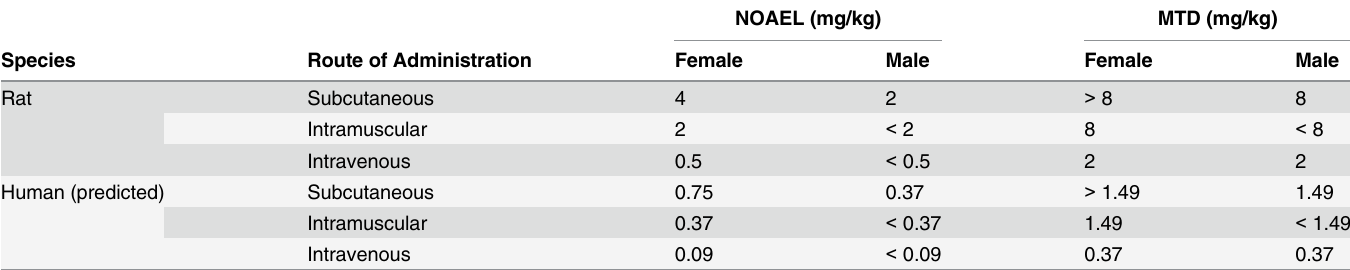
Table 5. Estimation of allopregnanolone no observable adverse effect level (NOAEL) and maximally tolerated dose (MTD) in male and female rats and predicted human NOAEL and MTD by multiple routes of administration.